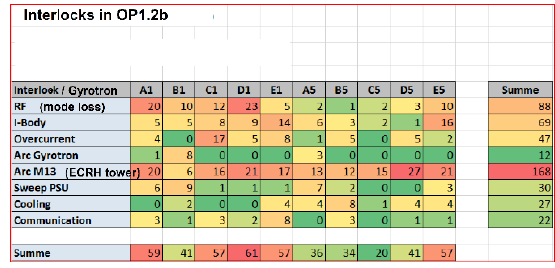
Fig. 5. List the interlocks of the individual gyrotrons that occurred in operation phase 1.2b and their causes.